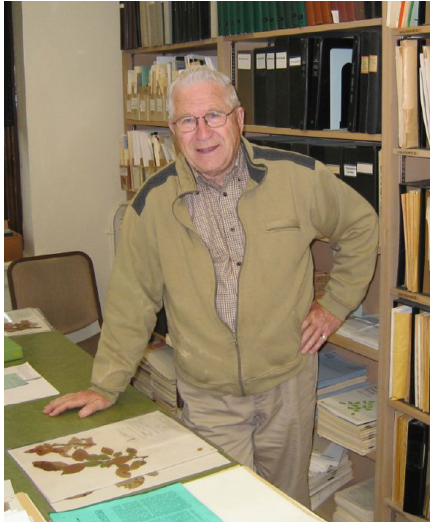
Fig. 19 John Parmelee (1924–2022) in the William Saunders Building, Central Experimental Farm, Ottawa, June 2008. Photo : Scott